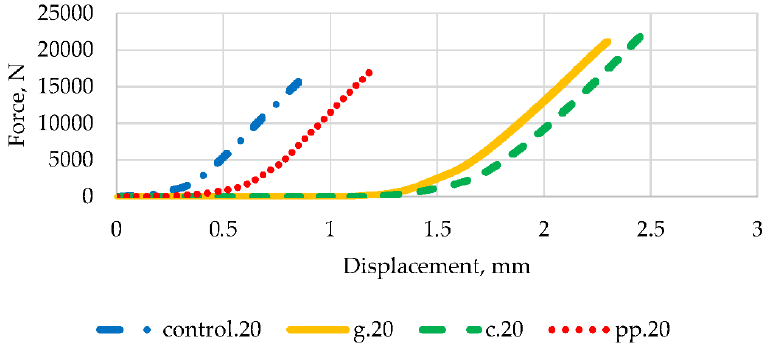
Figure 16. Load vs. displacement curves for 20 ◦ angle and all types of mortar.